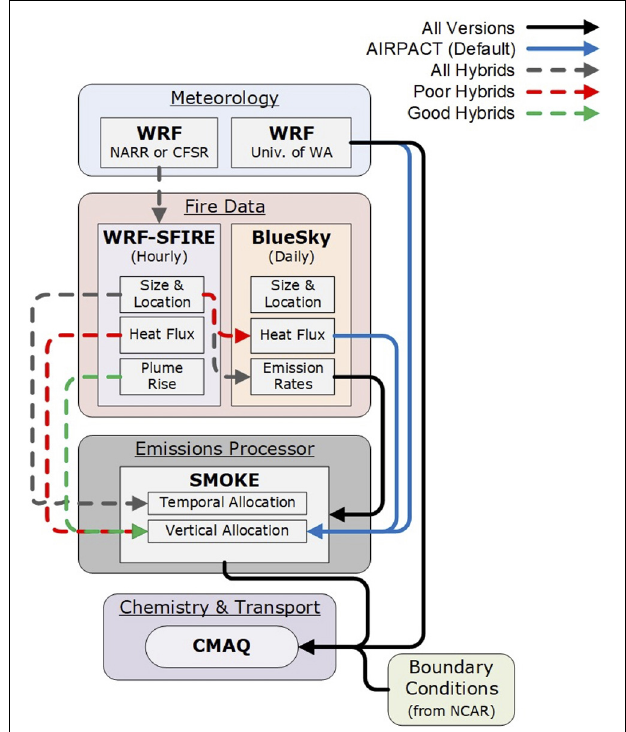
FIGURE 2 | Data flow and coupling between the fire model WRF-SFIRE and AIRPACT air quality (AQ)